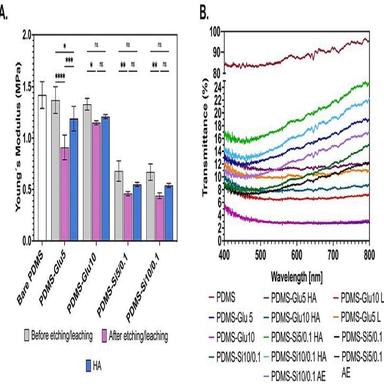
A. Younǵs modulus of PDMS-modified MNs. Error bars represent SD (n = 3). \ Significant differences between different treatment conditions in the same sample (n = 10). 0.1234 (ns); 0.0332 (\), 0.0021 (\\), 0.0002 (\\\), <0.0001 (\\\\). B. Optical transmittance of all PDMS-modified samples. Legend: L-after leaching, AE- after etching, HA- Hyaluronic acid.